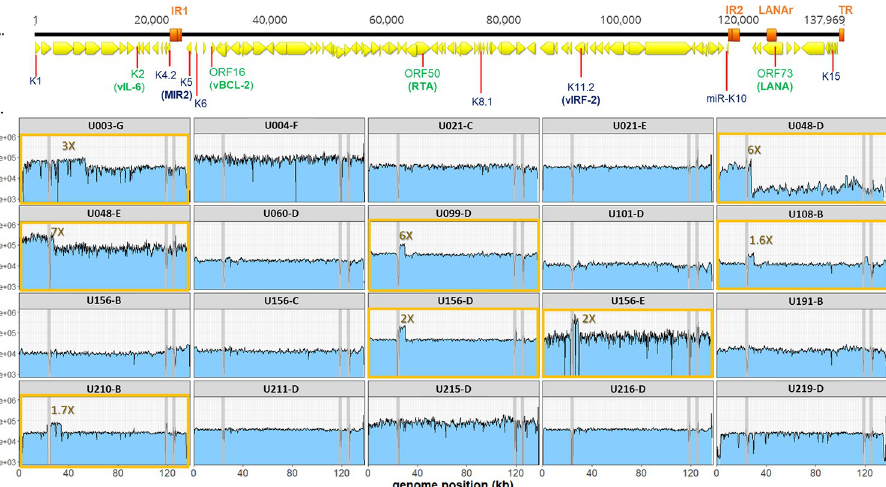
Fig 1. Raw read coverage of KSHV genomes detected in 20 tumors from 16 individuals. (A.) Linear schematic of KSHV genome. Yellow arrows represent open reading frames, as annotated in KSHV reference strain GK18. Orange bars represent the major repeat regions Internal Repeat 1 (IR1), Internal Repeat 2 (IR2), LANA repeat domain (LANAr) and Terminal Repeats (TR). Viral genes of note in this study are indicated, with their protein products in parenthesis. Those encompassing amplicons used for ddPCR quantitation are labeled in green. (B.) Raw read coverage of KSHV genome sequences from 20 tumor biopsies. The yellow boxes highlight the 8 tumors with the KSHV IR1 region overrepresented. The grey vertical lines represent the major repeat regions where sequence mapping was unreliable.